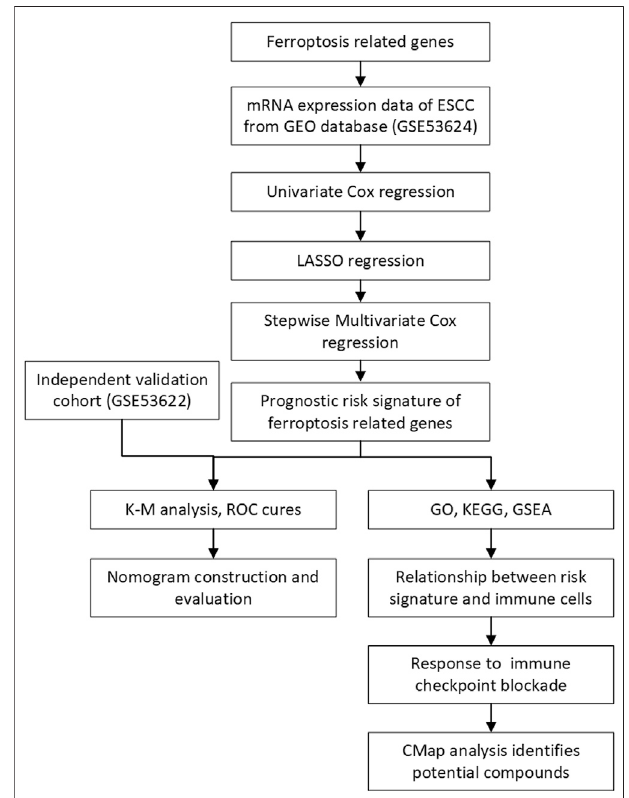
FIGURE 1 | Flowchart of the construction of the prognostic FRG